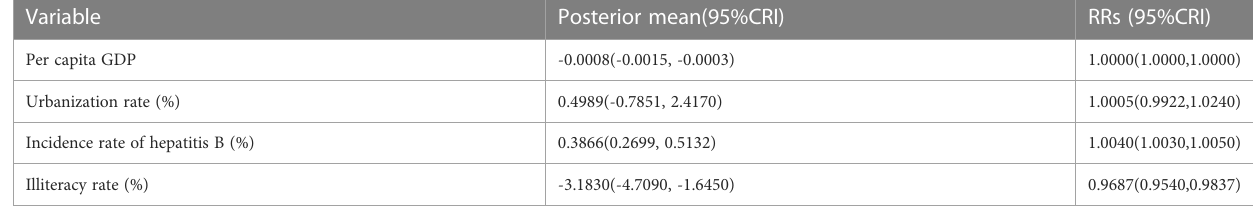
TABLE 4 Quanti fi ed posterior mean values and relative risks (RRs) of potential driving factors of hepatitis C in China from 2010 to 2018. Variable